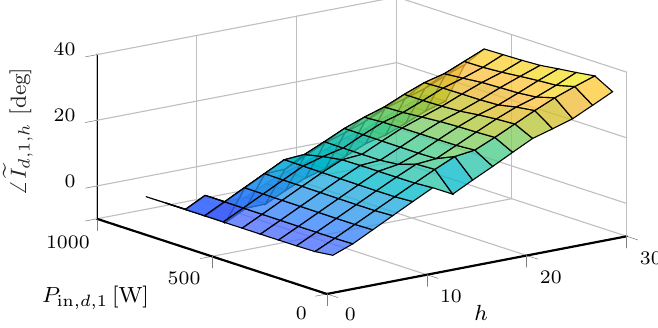
Figure 10. Contour plot of the measured current phase angle of the nonlinear unwrapped device as a function of harmonic number and input